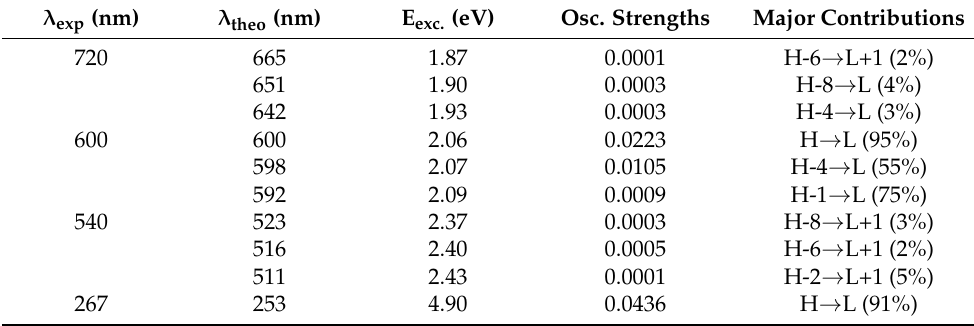
Table 4. Experimental absorption wavelengths ( λ exp ), calculated absorption wavelengths ( λ theo ), exci- tation energies (E exc. ), oscillator strengths, and significant contributions of the electronic transitions of [Cu(Citr) 2 ] n calculated at the level of theory mPW1PW91/6-31G(d)-LANL2DZ and ECP=LANL2DZ. λ exp (nm) λ theo